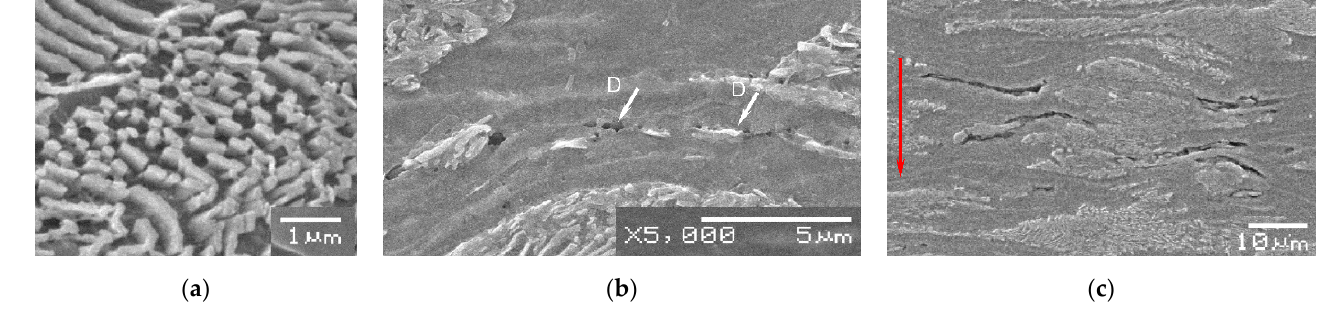
Figure 10. Microstructural damage for strain level ε z 4 = 1.59: ( a ) submicroscopic particles of lamellar cementite; ( b ) nucleation of microcracks in the central zone of the sample; ( c ) microcracks in the peripheral zone of the sample (×5000 magnification, red arrow—direction of upsetting).